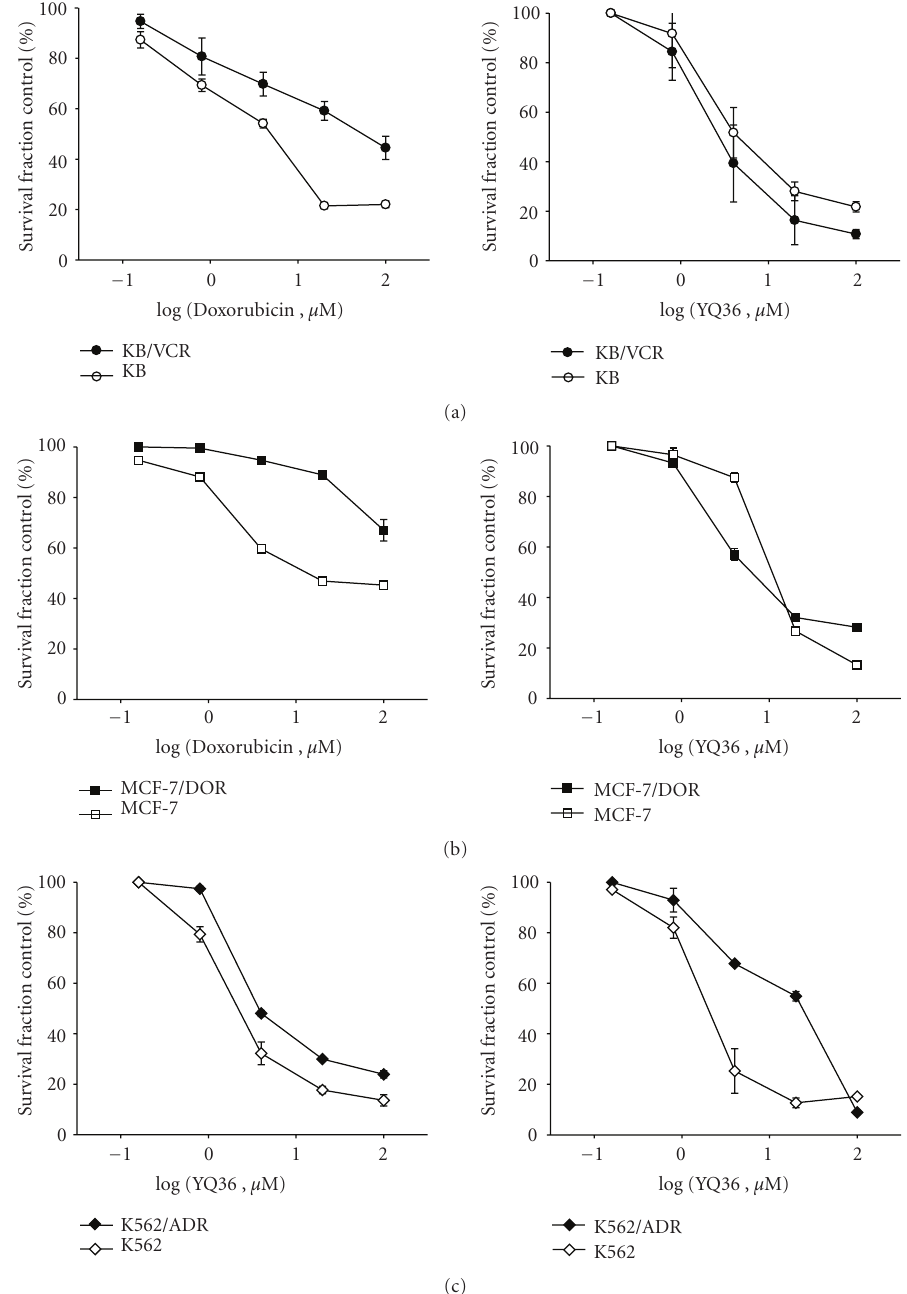
Figure 2: YQ36 inhibited the proliferation on three panels of chemosensitive tumor cells and their chemoresistance subline. (a) Human oral squamous carcinoma cell lines (KB and KB/VCR) were treated with YQ36 or DOX (0.16–100 μ M) for 48 hours. Points represent the mean fractional survival; error bars represent standard deviation. (b) Human breast cancer cell lines (MCF-7 and MCF-7/DOR) were treated with YQ36 or DOX (0.16–100 μ M) for 48 hours. Points represent the mean fractional survival; error bars represent standard deviation. (c) Human leukemia cell lines (K562 and K562/ADR) were treated with YQ36 or DOX (0.32–100 μ M) for 48 hours. Points represent the mean fractional survival; error bars represent standard